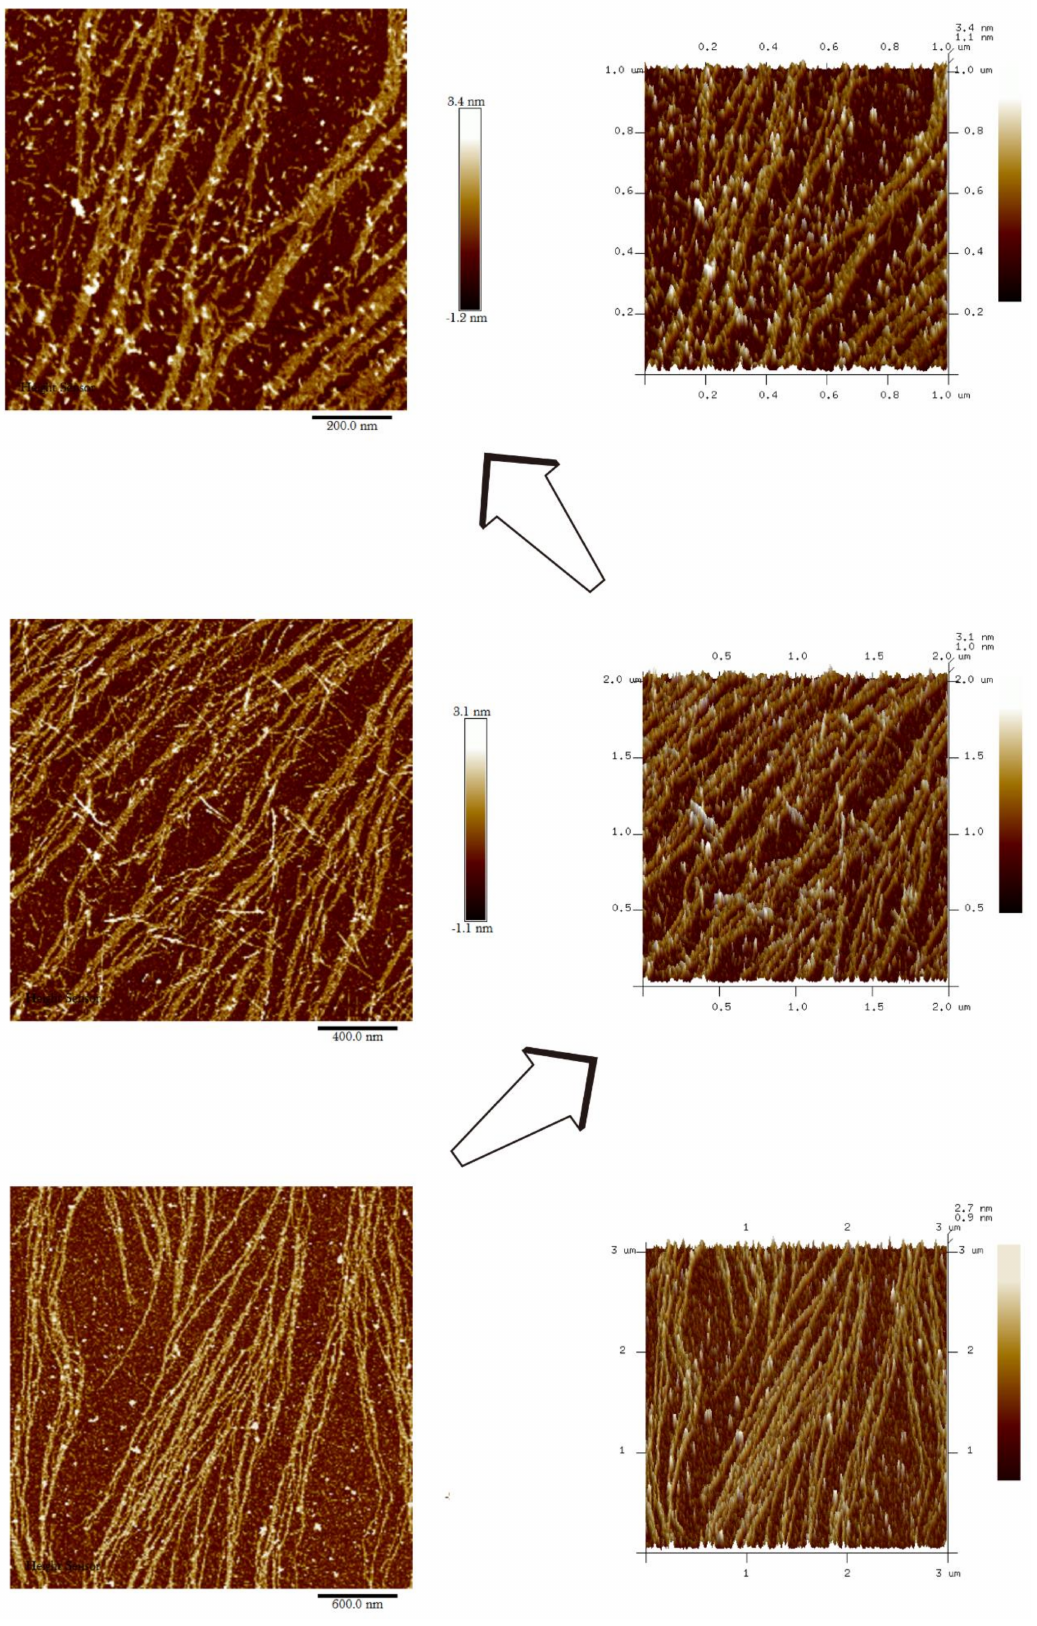
Figure 6. Atomic force microscopy analysis of